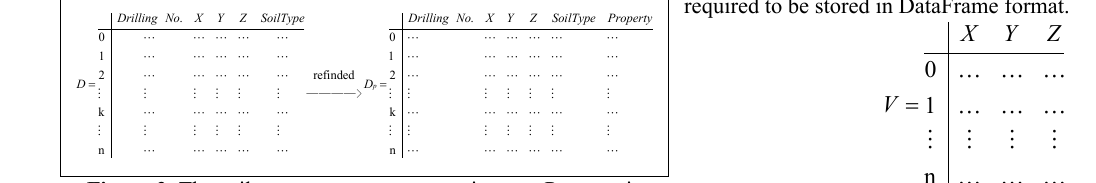
Figure 3 . The soil property parameters assignmentParametric modelling for the target cross section